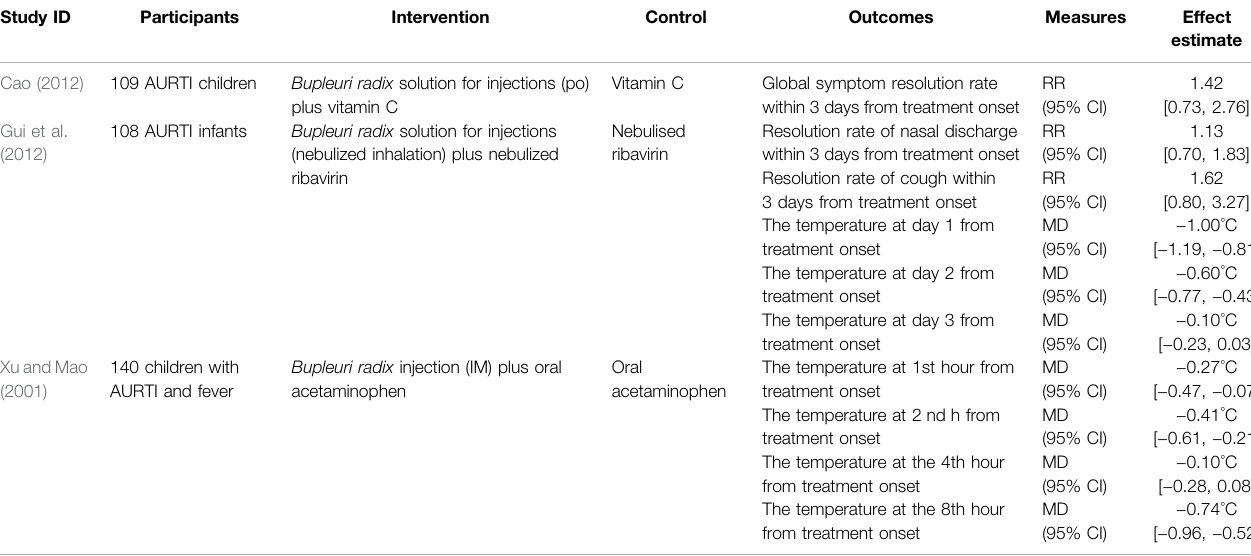
TABLE 3 | Bupleuri radix plus usual care versus usual care (3 trials).